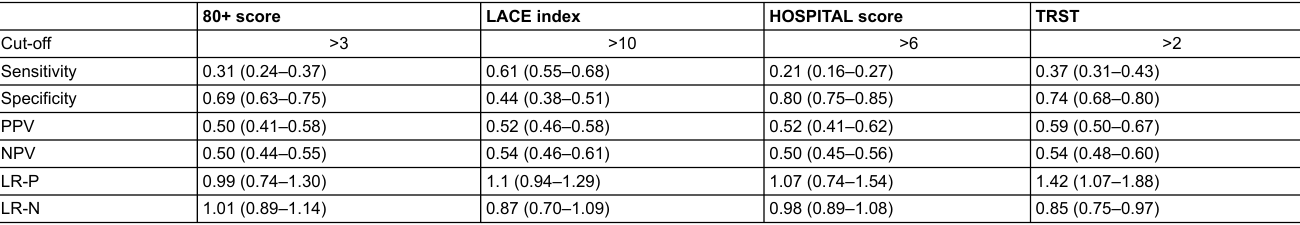
Table 7: Metrological characteristics.